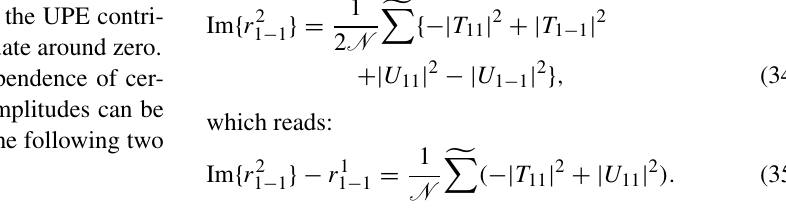
increasing W and p 2 , which indicates that the UPE contri- T bution becomes smaller, while u 2 , u 3 fluctuate around